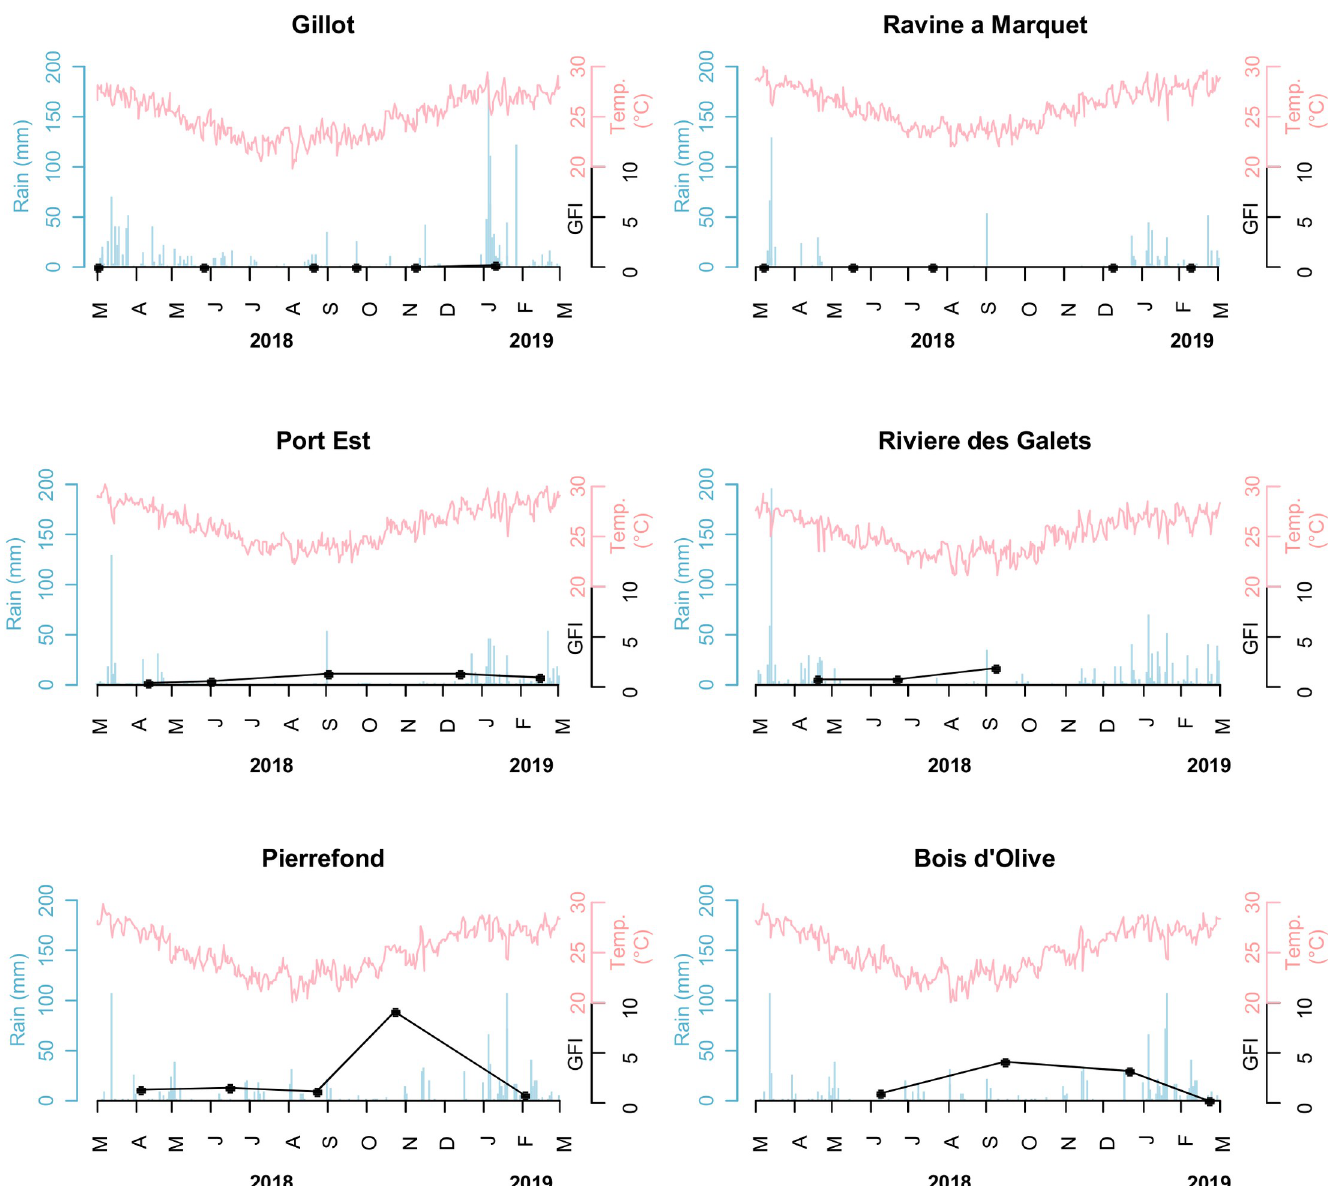
Fig 2. Dynamics of Xenopsylla genus flea index in six study sites, Reunion Island, 2018–2019. The GFI, rainfall and temperature are plotted in black, blue and red colors, respectively.